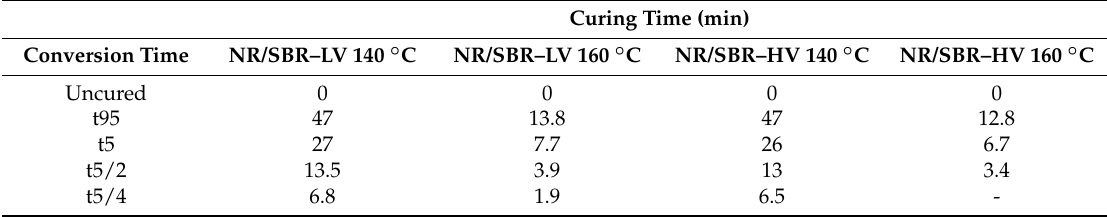
Table 3. Overview of curing times at the two curing temperatures. Curing times indicate the conversion level: t95 defines the time for 95% conversion and t5 refers to the time for 5%